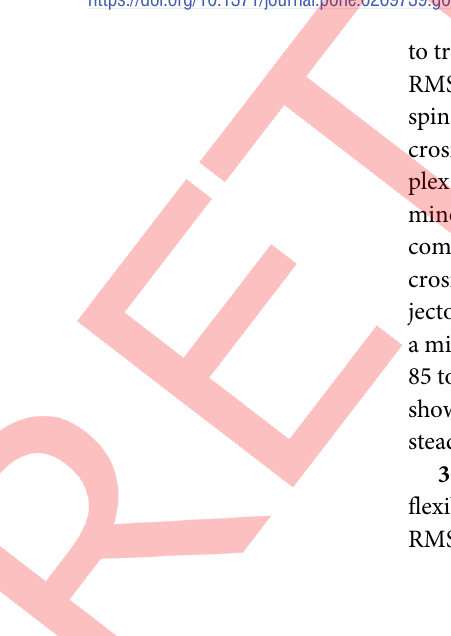
Fig 3. Docked Citicoline & Oxalyldiaminopropionic acid with ET-1; side chains atoms of Lys161, Lys97 making hydrogen bonds. Docked pose of compounds highlighting the most active residues of protein’s binding pocket is shown above.